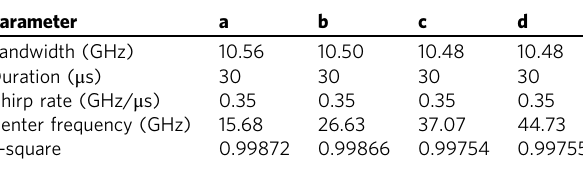
Table 2 Summary of the parameters of the LCMW in Fig. 6.